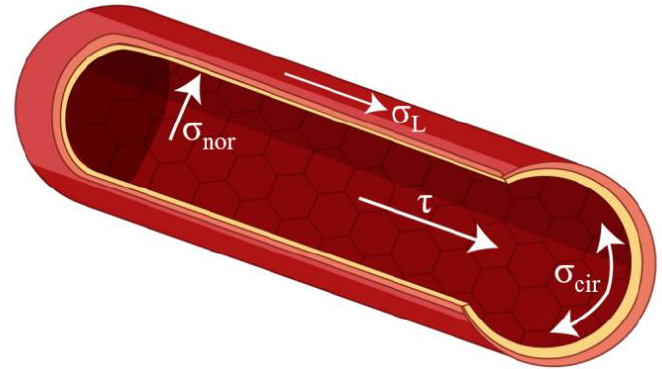
Figure 3. The mechanical stresses on blood vessels.